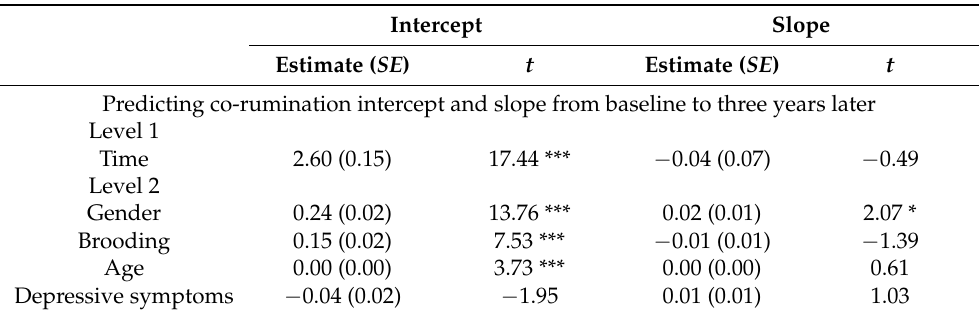
Table 3. Multi-level analyses predicting co-rumination trajectories as a function of the covariates and gender.